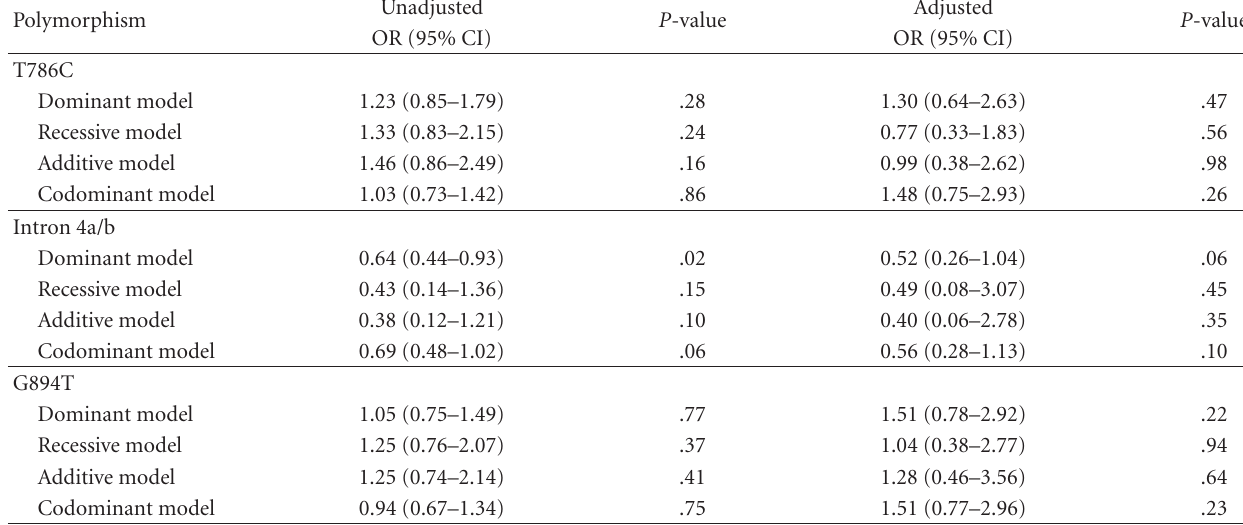
Table 3: Unadjusted and adjusted odds ratios with the corresponding 95% confidence intervals for the association of NOS3 genotypes and hypertension: comparisons for the dominant, recessive, additive, and codominant models of the mutant alleles (786C ∗ , 4a ∗ , 894T ∗ ).